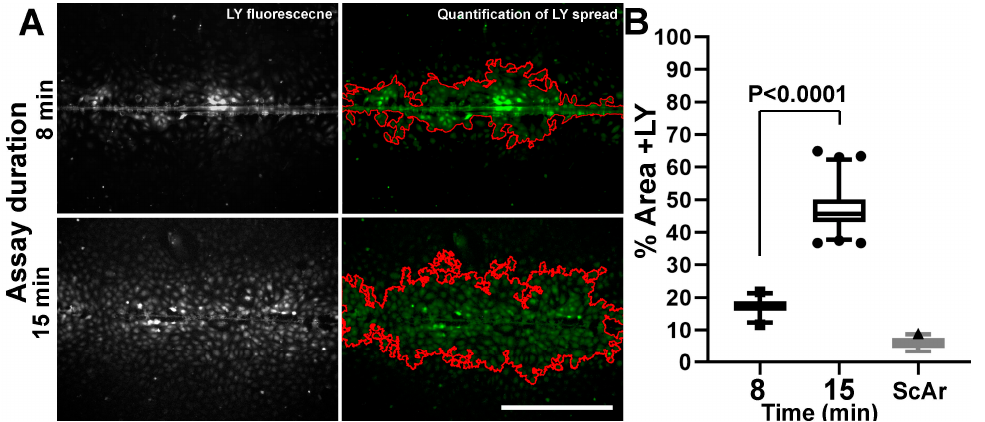
Figure 7. Confluent HUVEC monolayers are functionally gap junction coupled. ( A ) left panels: fluorescence images of HUVEC monolayers exposed to dye transfer buffer for 8 or 15 min as indicated, prior to fixation and imaged using an EVOS M5000 microscope equipped with a 10× 0.3 NA air objective. Right panels show the area of LY spread (red lines) in the images determined by the automated macro Cut Analyzer.ijm [48]. ( B ) Quantification of the time-dependent increase in area of LY spread fluorescence following 8 ( n = 37 measurements from 3 independent experiments) or 15 min ( n = 63 measurements from 3 independent experiments) after scratch formation. The mean area of the physical scratch lesion is shown for reference (ScAr). Data are expressed as box and whisker plots with median (horizontal bar), 25–75 percentile (box) and 5–95 percentiles (vertical bars). p < 0.0001, t -test, GraphPad Prism. Scale bar is 500 μ m.